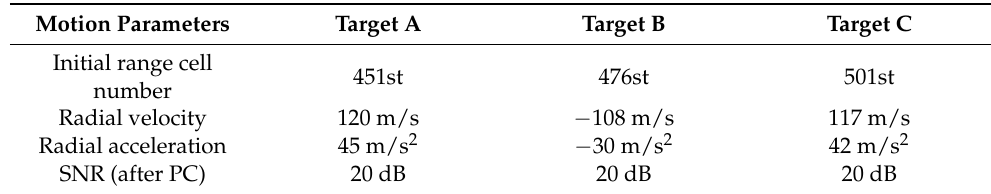
Table 3. Motion parameters of three maneuvering